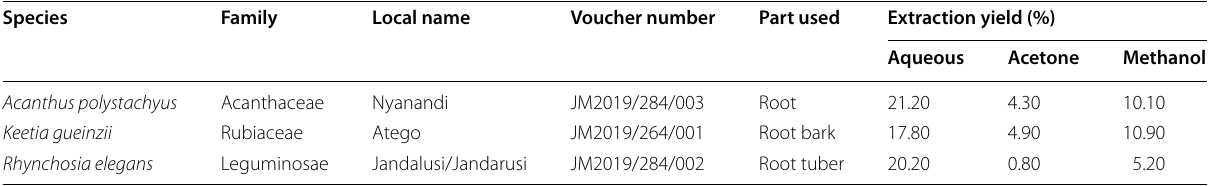
Table 1 Ethnobotanical information on the plant species used in this study and their extraction yield Species